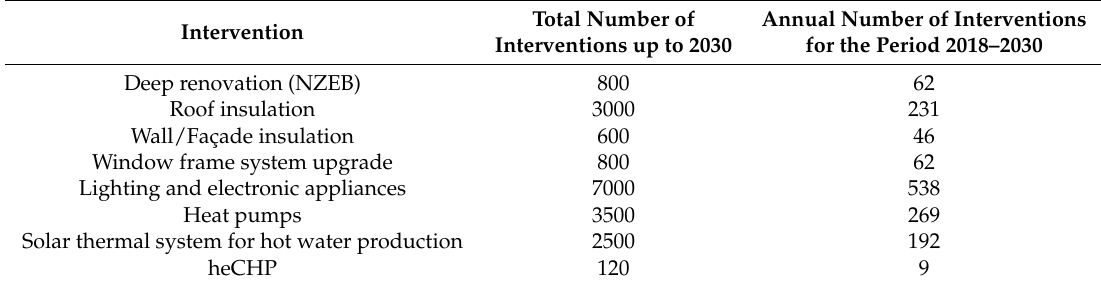
Table 11. Proposed number of energy efficiency interventions in existing buildings of the tertiary sector of Cyprus up to